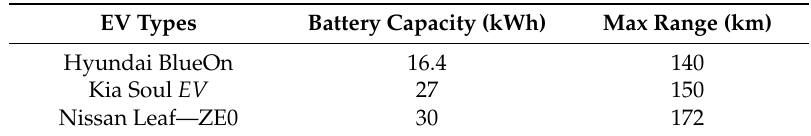
Table 4. EV specification [31].